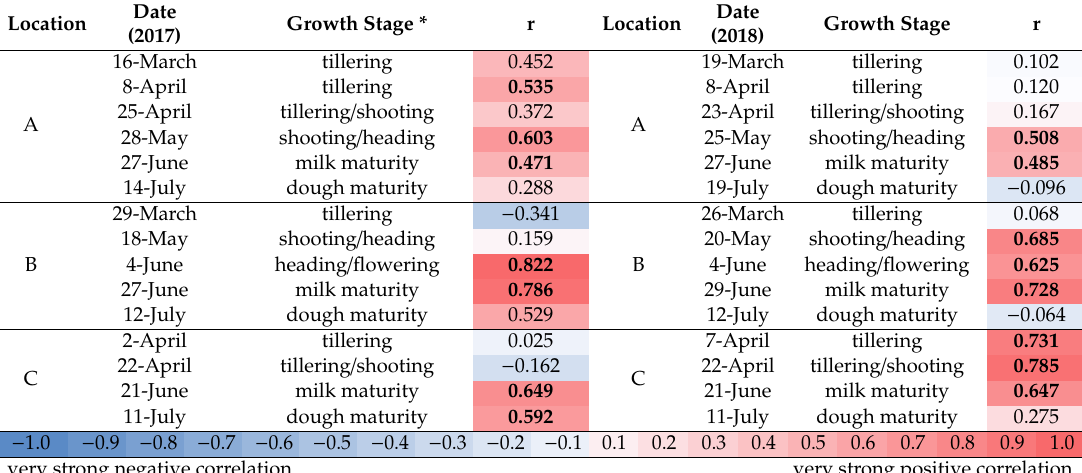
Table 6. Correlation coe ffi cients (r) between NDVI values and number of spikes per square meter for three locations in 2017 and 2018. The background color of the cells with the correlation coe ffi cient values indicates the strength of the relationship (significant correlations at α = 0.05 are given in